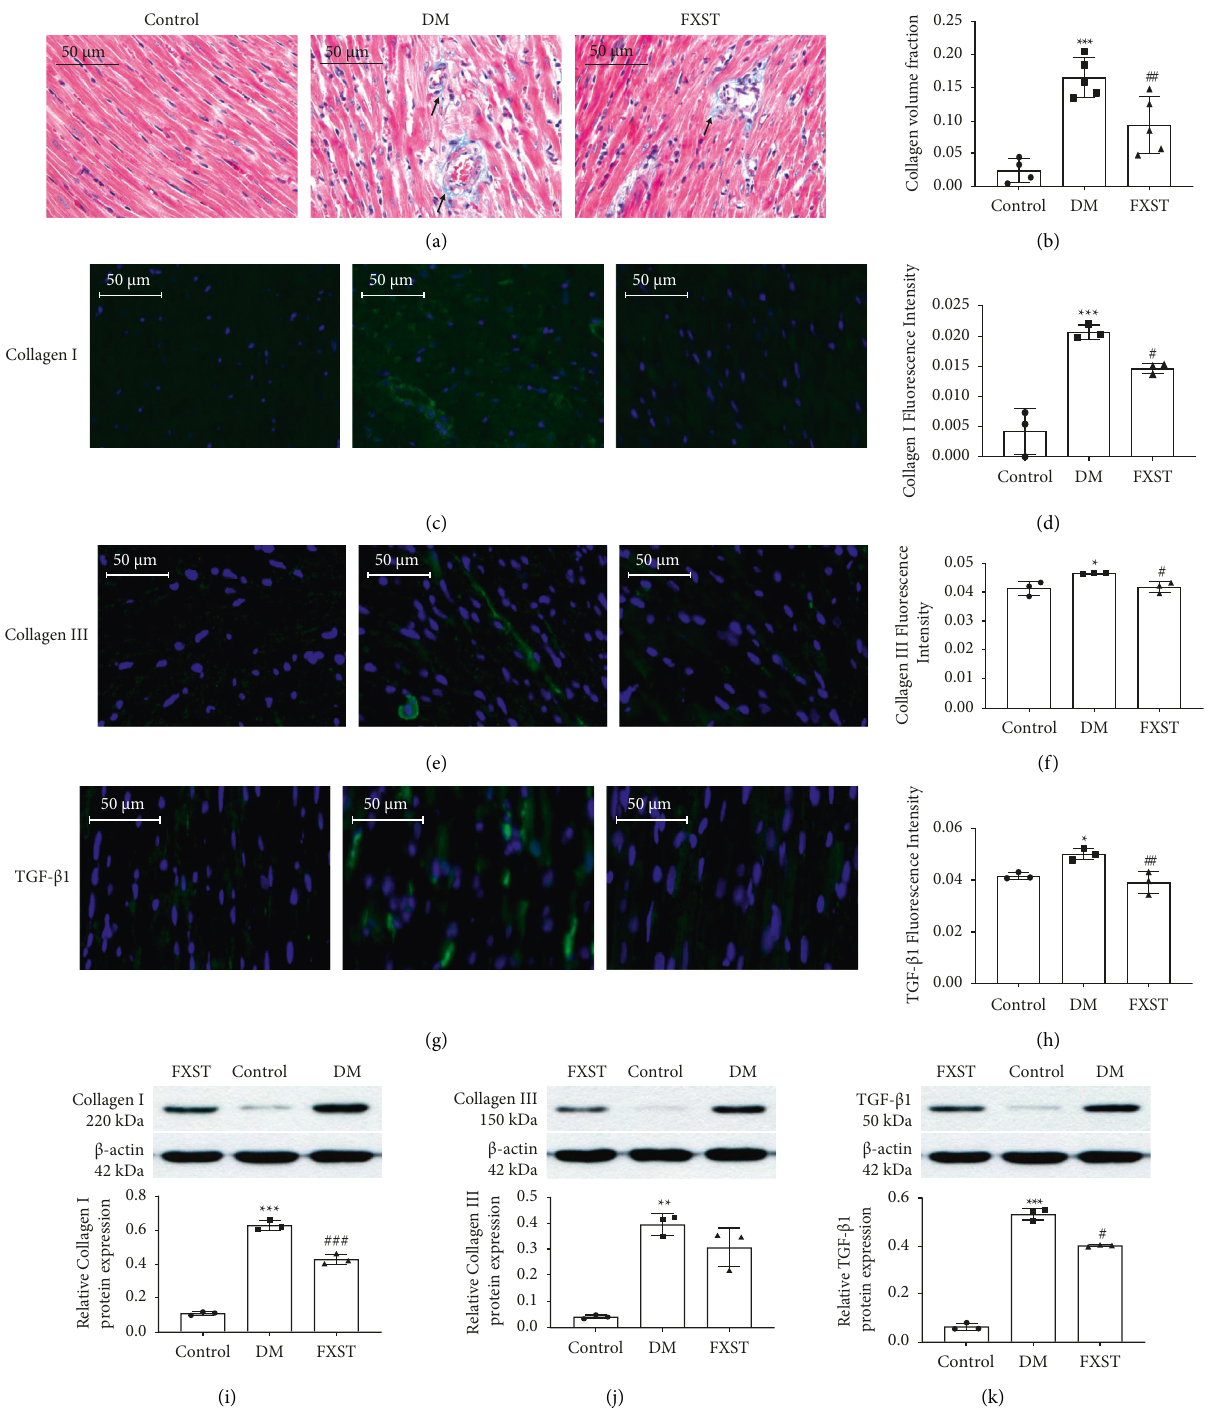
Figure 4: FXST alleviated STZ-induced cardiac fibrosis in DM rats. (a) Representative images of Masson staining of myocardial tissues (400 , magnification). Arrows represent the fibrotic area. (b) The quantification analysis of the collagen volume fraction of myocardial × tissues. Representative immunofluorescence images were shown for the expression of collagen I (c), collagen III (e), and TGF- β 1 (g). The expression level of collagen I (d), collagen III (f), and TGF- β 1 (h) was detected and quantified. (i–k) Western blot was used to determine the protein expression of collagen I, collagen III, and TGF- β 1 in the myocardial tissues of rats in each group. Data are expressed as the mean SD ( n 3–5 for each group). Scale bar 50 μ (cid:31) (cid:31) ±